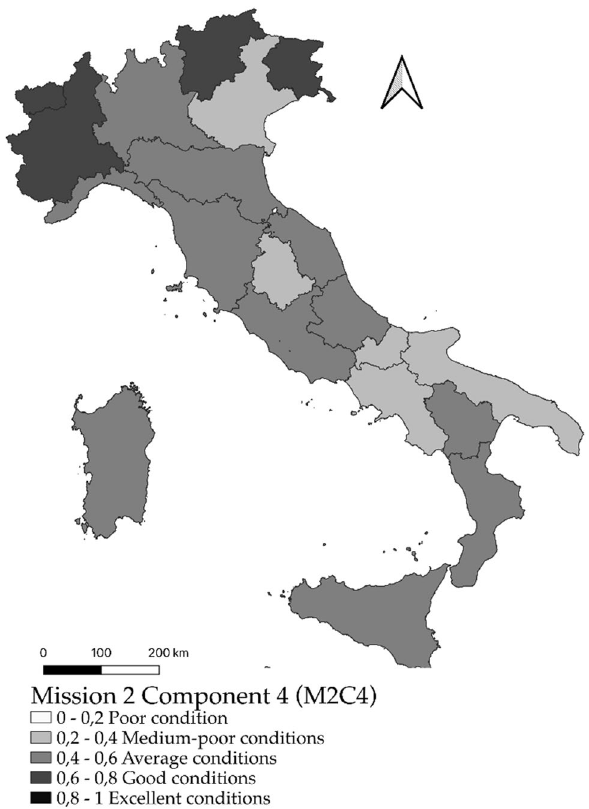
Figure 4. Territorial distribution by region of the fuzzy values for Mission 2 Component 4 (Protection of land and water